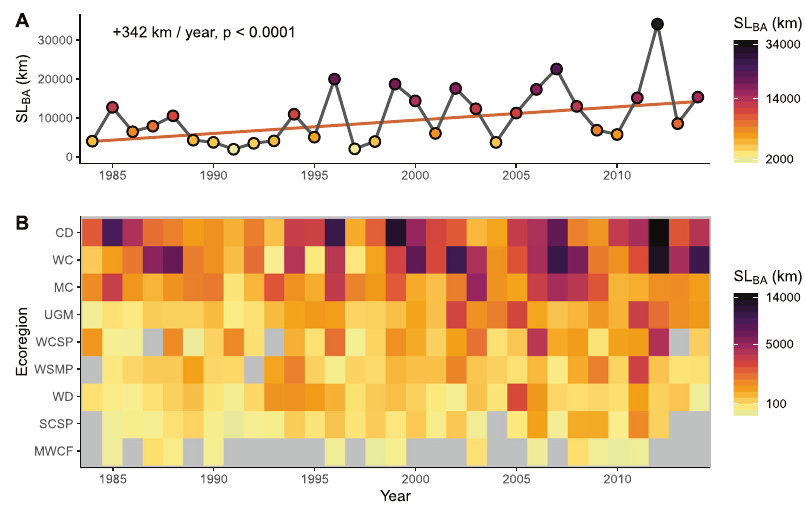
Fig. 2 Stream + river length impacted within burned areas (SL BA ). A The trend of SL BA for all ecoregions combined through the study period. B Trends divided into individual ecoregions, ordered from smallest number of wild fi res (bottom) to largest (top), show large variations in annual SL BA patterns. Gray squares indicate year/ecoregion combinations where no wild fi res were reported that match the Monitoring Trends in Burn Severity criteria. The ecoregion acronyms are Cold Deserts (CD), Marine West Coast Forest (MWCF), Mediterranean California (MC), South Central Semiarid Prairies (SCSP), Upper Gila Mountains (UGM), Warm Deserts (WD), West-Central Semiarid Prairies (WCSP), Western Cordillera (WC), Western Sierra Madre Piedmont (WSMP).